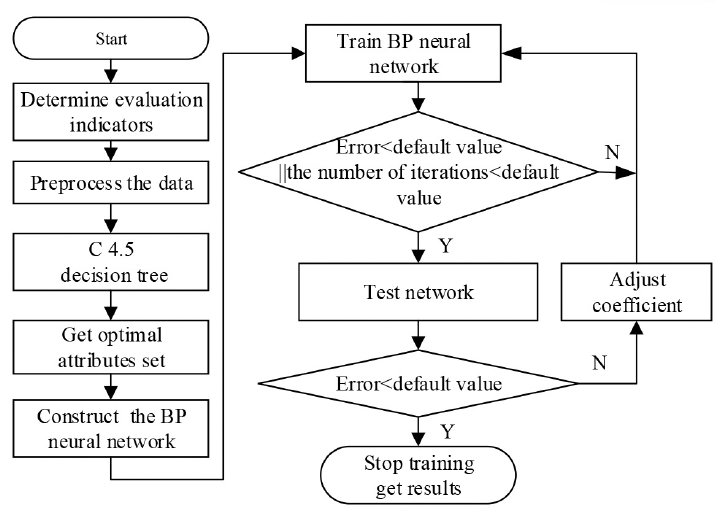
Fig. 1 Procedure of performance evaluation for laboratories with the use of the decision tree and BP neural network. trained though as many as training samples, the prediction network will be obtained. After being tested and adjusted, the prediction network could be used to predict the result of the performance evaluation. The performance evaluation method is shown in Figure